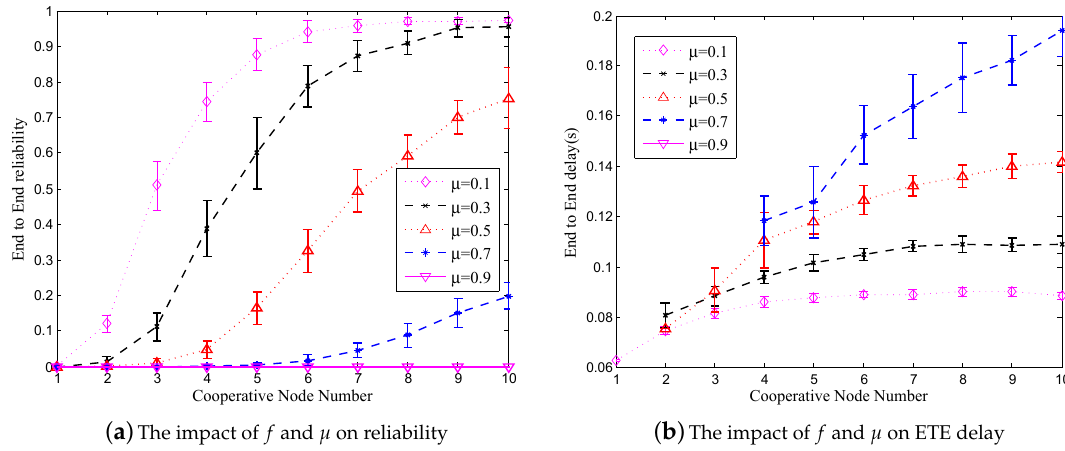
( b ) The impact of f and µ on ETE delay Figure 8. The impact of f and µ on reliability and ETE delay in